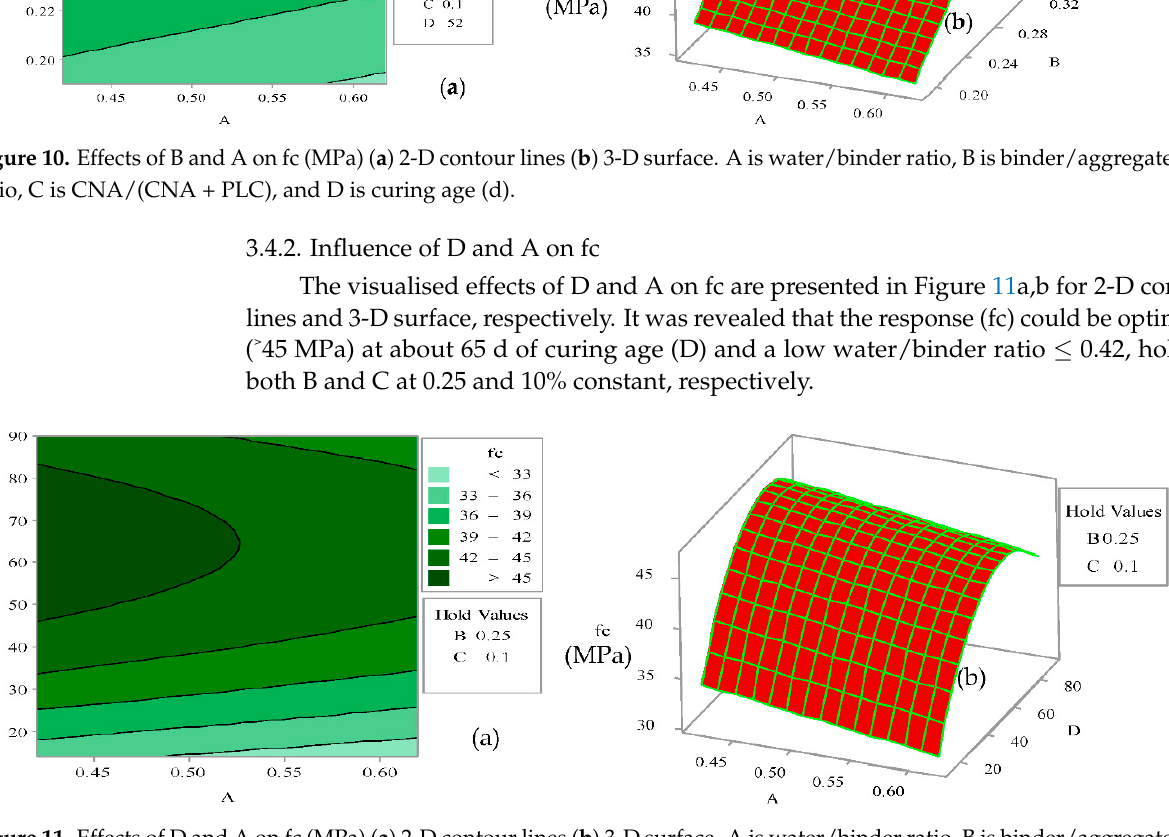
Figure 11. Effects of D and A on fc (MPa) ( a ) 2-D contour lines ( b ) 3-D surface. A is water/binder ratio, B is binder/aggregate ratio, C is CNA/(CNA + PLC), and D is curing age (d).